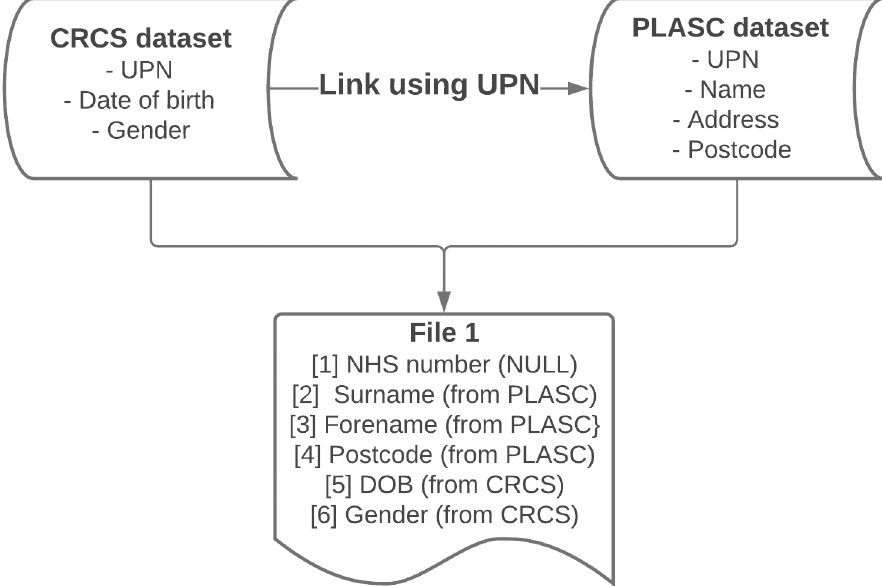
Figure 1: The method used by Welsh Government to generate the file used by the trusted third party in the linkage